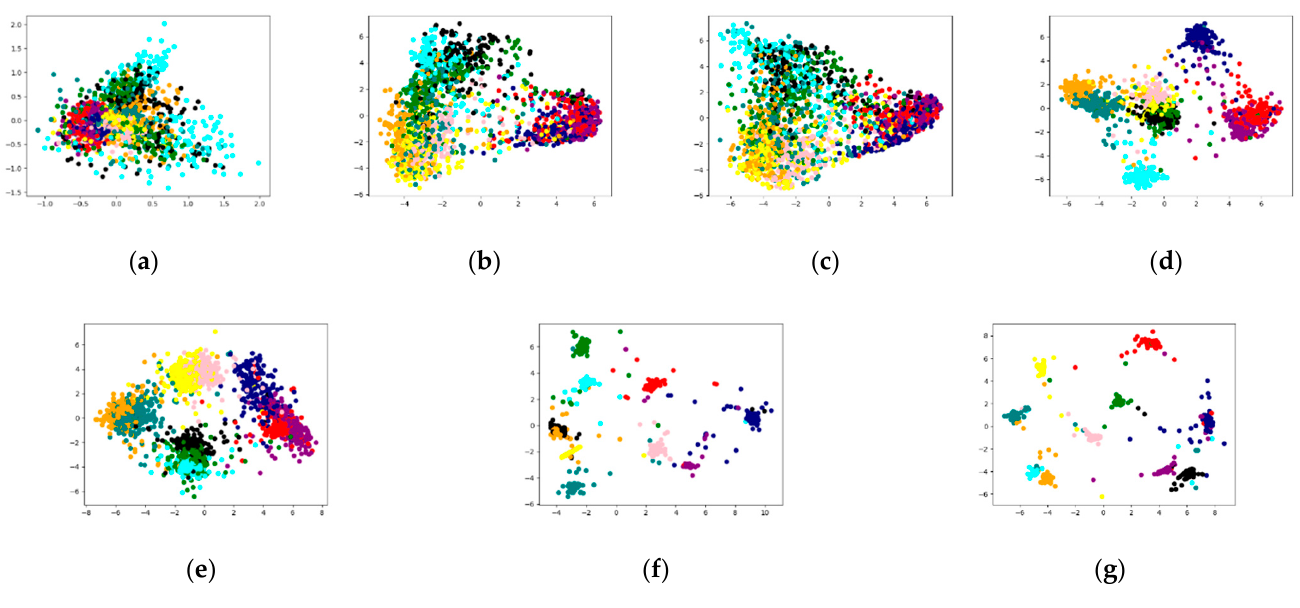
Figure 7. Two-dimensional ISOMAP projection. a-h are the two-dimensional visualization results of the extracted features of several models. ( a ) original data, ( b ) RNN, ( c ) LSTM, ( d ) Transformer, ( e ) R-Transformer, ( f ) R-DeLighT, ( g ) R-DeLighT + Autoclip.